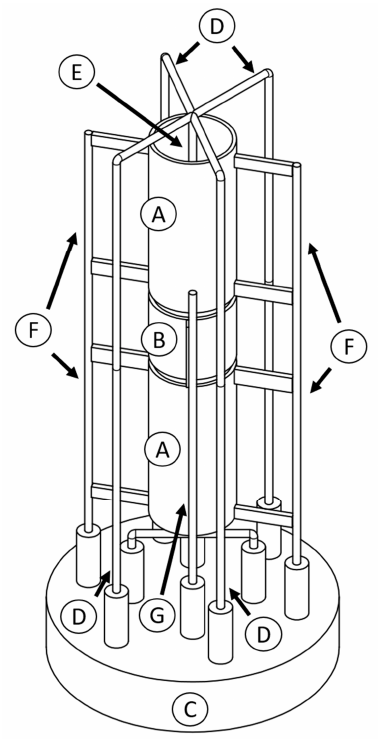
Figure 7. A scheme for a possible gauge redesign based on the results of the proof-of-concept gauge and its shortcomings. This design includes guard rings and minimizes structural-nonconducting surfaces to avoid leakage currents from cesium deposition. (A) indicates the guard-rings which produce no measurements. They are held up by structural wires indicated by (F). (B) indicates the central measurement ring, held up and isolated from the other elements by the structural wires indicated by (G). The cylindrical filament is indicated by (E) and is held taught by structural wires indicated by (D). All structural wires are connected to a feedthrough indicated by (C) using ceramic